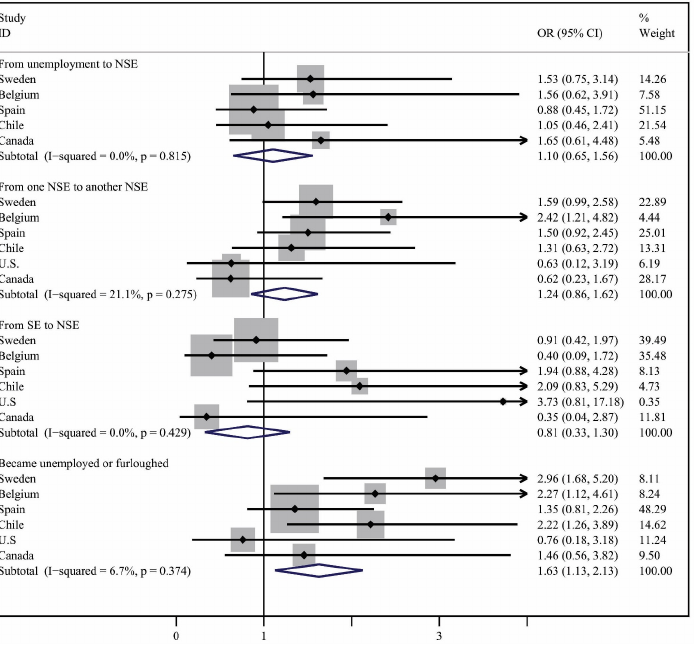
Figure 3. Pooled logistic regression analysis of predictors of severe or extreme anxiety or depression. Notes: SE = standard employment; NSE = non-standard employment arrangement. Reference category = same NSE. Model adjusted for age, gender, and education.